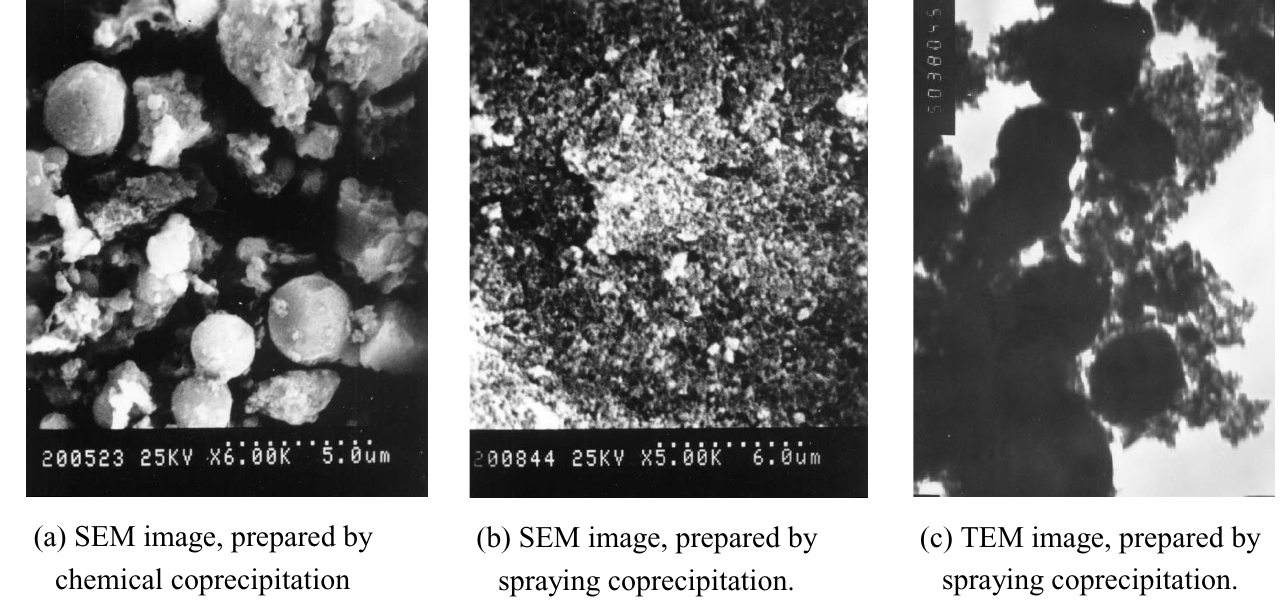
Figure 3. SEM and TEM image of ZnGa2O4 powder.